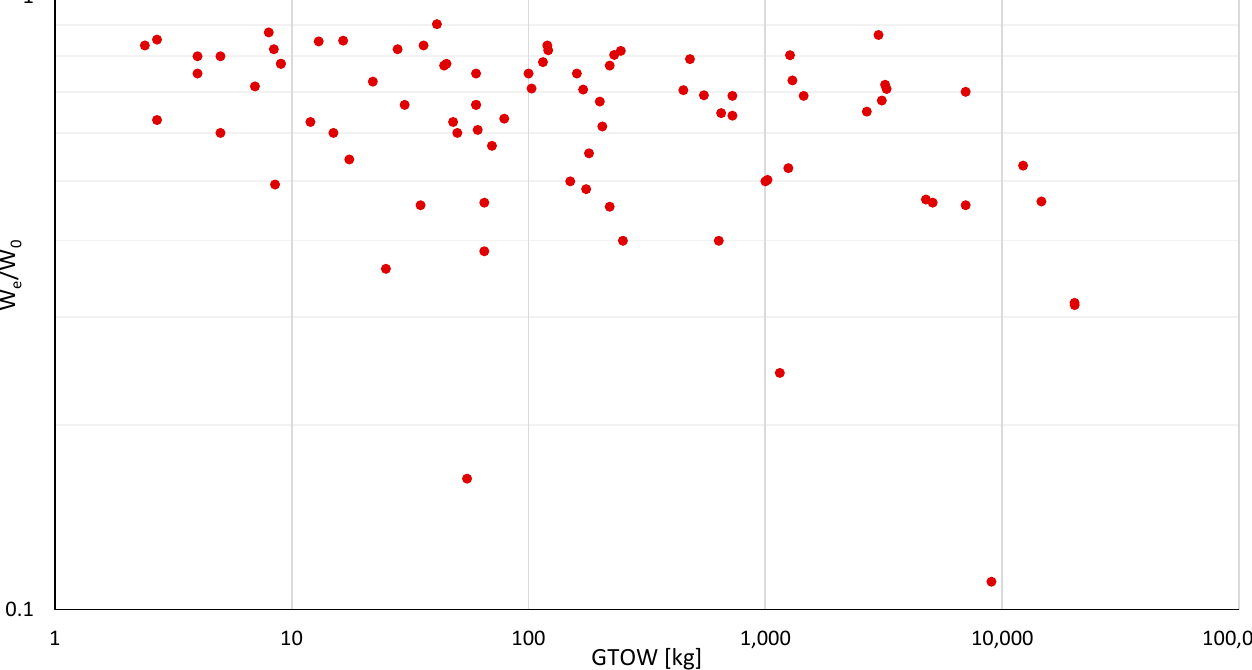
Figure 14. Empty weight divided by GTOW as a function of GTOW for the general category.